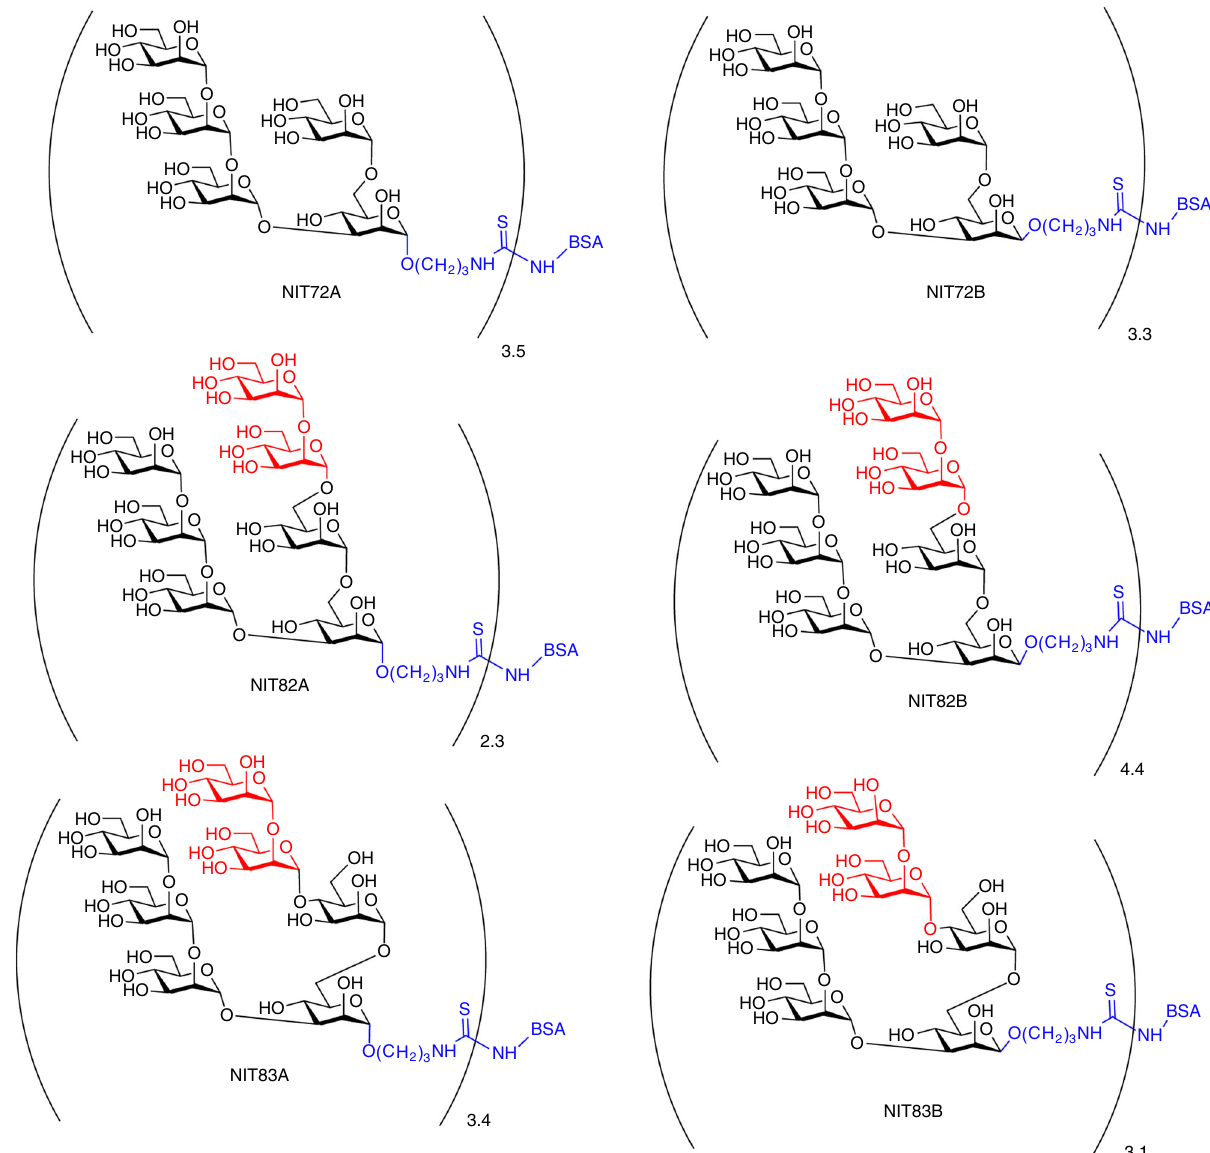
Fig. 2 Rv3-derived neoglycoconjugates. Synthetic versions of Rv3 and Rv3 derivatives incorporating a D3-like arm were coupled to BSA via lysine residues to generate neoglycoconjugates. The average number of ligand molecules per BSA for each conjugate is shown beside each bracket and was determined by MALDI-TOF (Supplementary Figs 27-32). NIT72A and NIT72B are BSA conjugates with α and β anomers, respectively, of synthetic Rv3 oligosaccharide. NIT82A and NIT82B are BSA conjugates of synthetic derivatives ( α and β anomers, respectively) of the Rv3 oligosaccharide with an α 1-6-linked D3-like arm extension, based on the model of the Rv3 oligosaccharide in complex with PGT128 (Fig. 1b). NIT83A and NIT83B are BSA conjugates carrying synthetic derivatives of the Rv3 oligosaccharide ( α and β anomers, respectively) with an α 1-4-linked D3-like arm extension, as suggested from modeling of the Rv3 oligosaccharide in the PGT128-binding site (Fig. 1b)